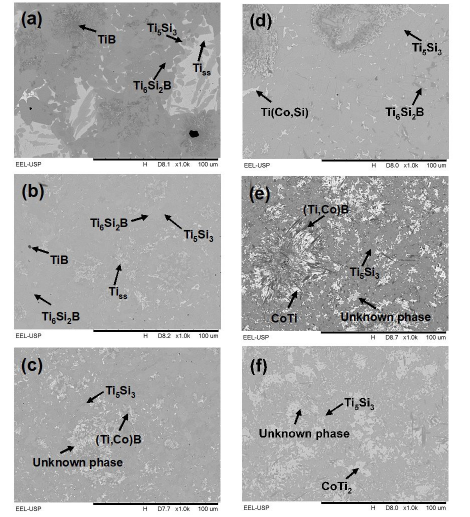
Figure 6. SEM micrographs of the SPSed (a-c) Ti-2Co-22Si-11B and (d-f) Ti-6Co-22Si-11B alloys produced with p’owders milled at different times: (a,d) 20 min, (b,e) 60 min, and (c,f) 300